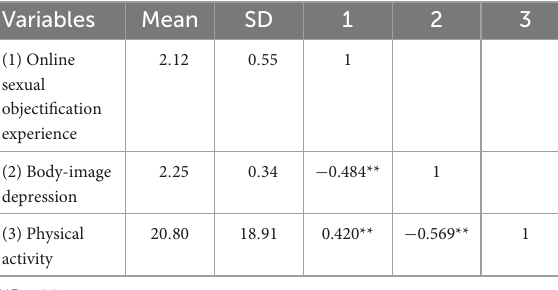
TABLE 2 Descriptive statistics and correlation analysis of all the